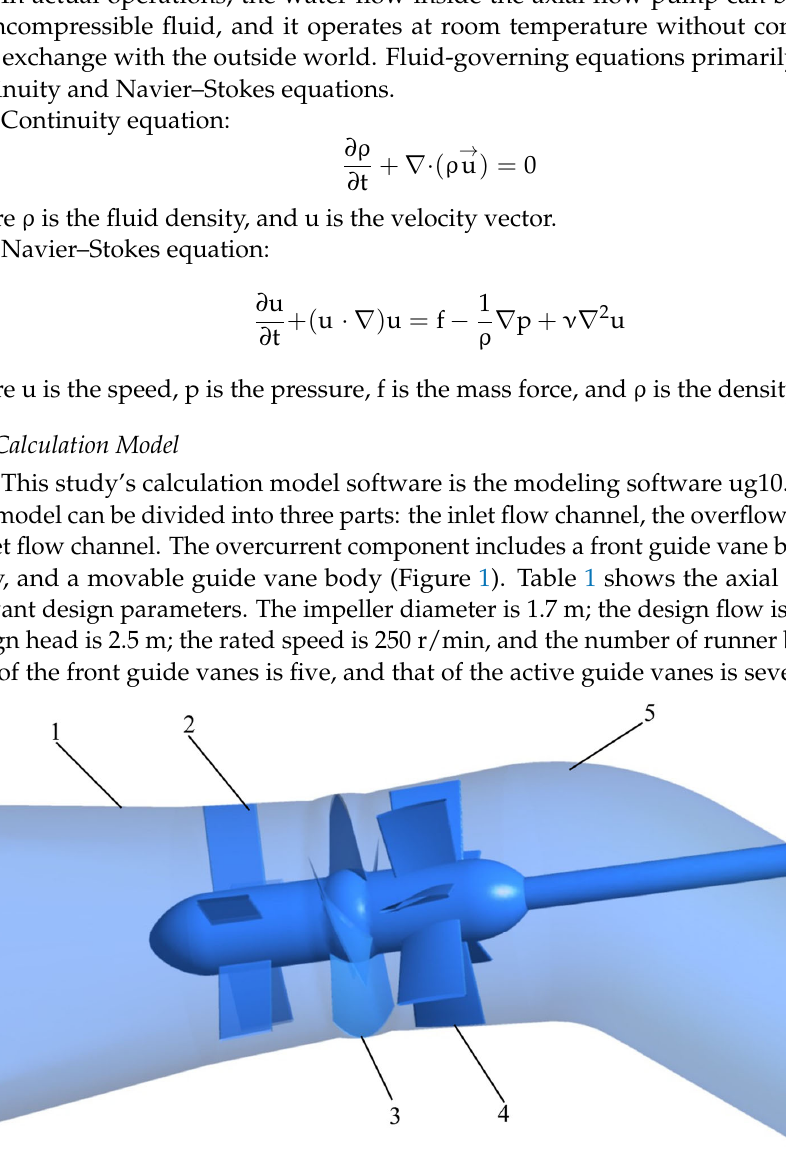
Figure 1. Flow channel diagram. 1. Inlet channel. 2. Front guide vane. 3. Runner. 4. Guide vane. 5. Outlet channel. Table 1. Parameters of axial flow pump.